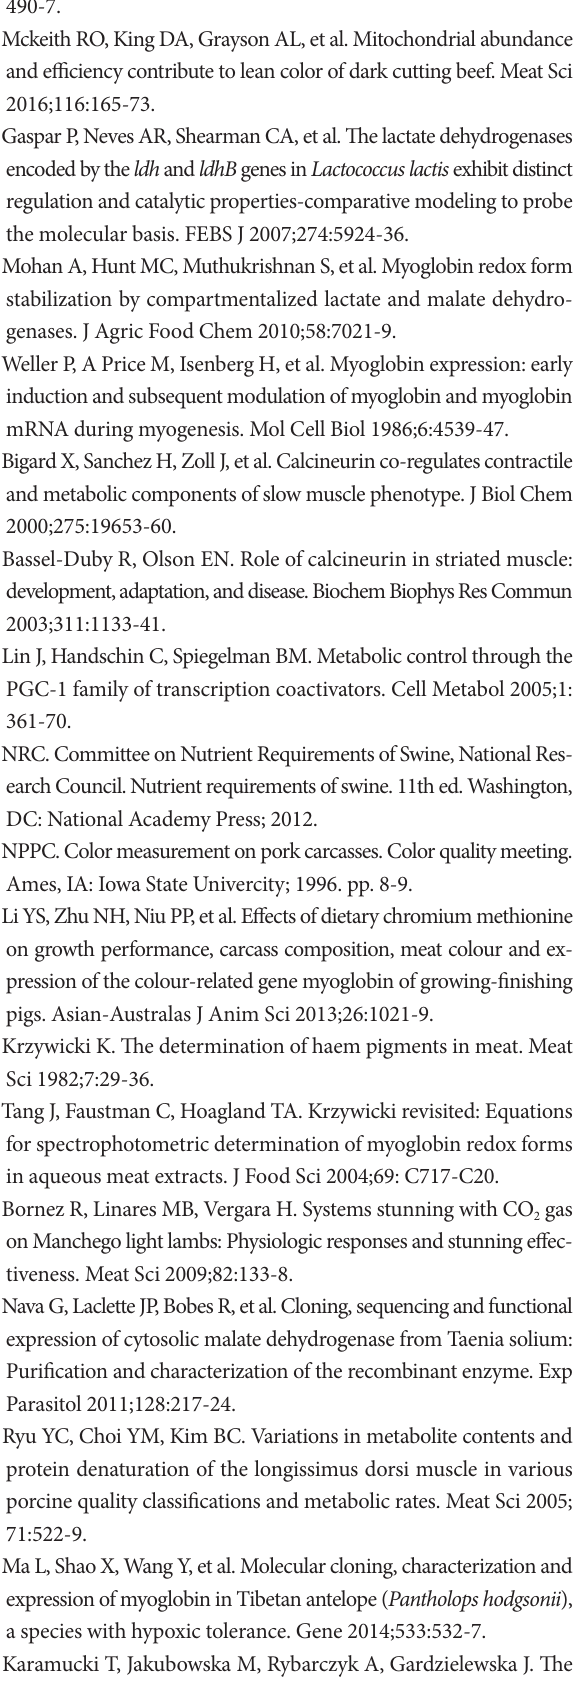
Figure 1 to 6. HZT, SGZ, TZ, and XHO participated in its design and coordination. JJZ revised the manuscript. All authors read and approved the final